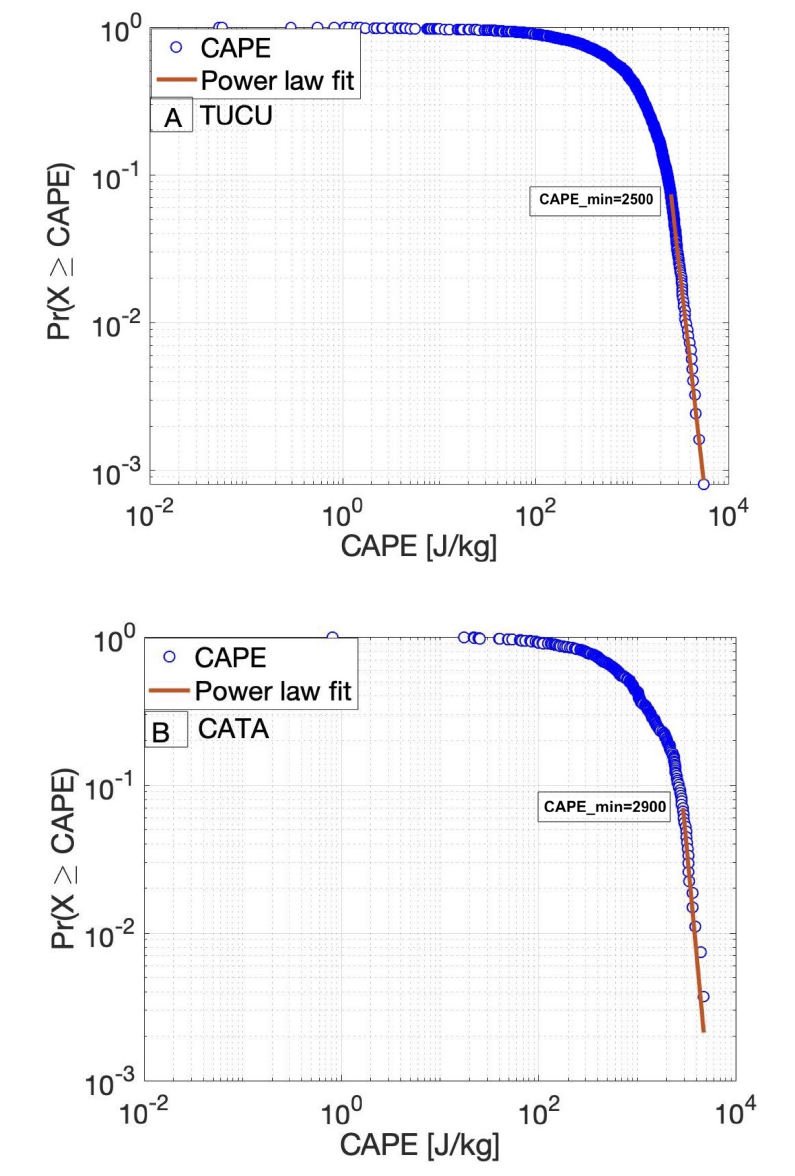
Figure 3. The power-law behaviour using a maximum likelihood approach of log-binned data for the independent variable CAPE ( A ) for TUCU and ( B ) for CATA following methods described in [50]. We identify a power-law like behaviour for CAPE values above 2500 J/kg (for TUCU) and 2900 J/kg (for CATA). The p -value greater than 0.1 (TUCU = 0.9, CATA = 0.4) confirms that a power law is a plausible hypothesis for the